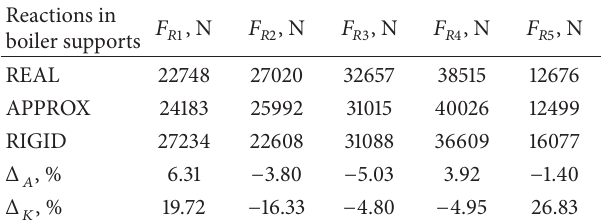
Table 6: Reactions in the boiler supports for the influence of total